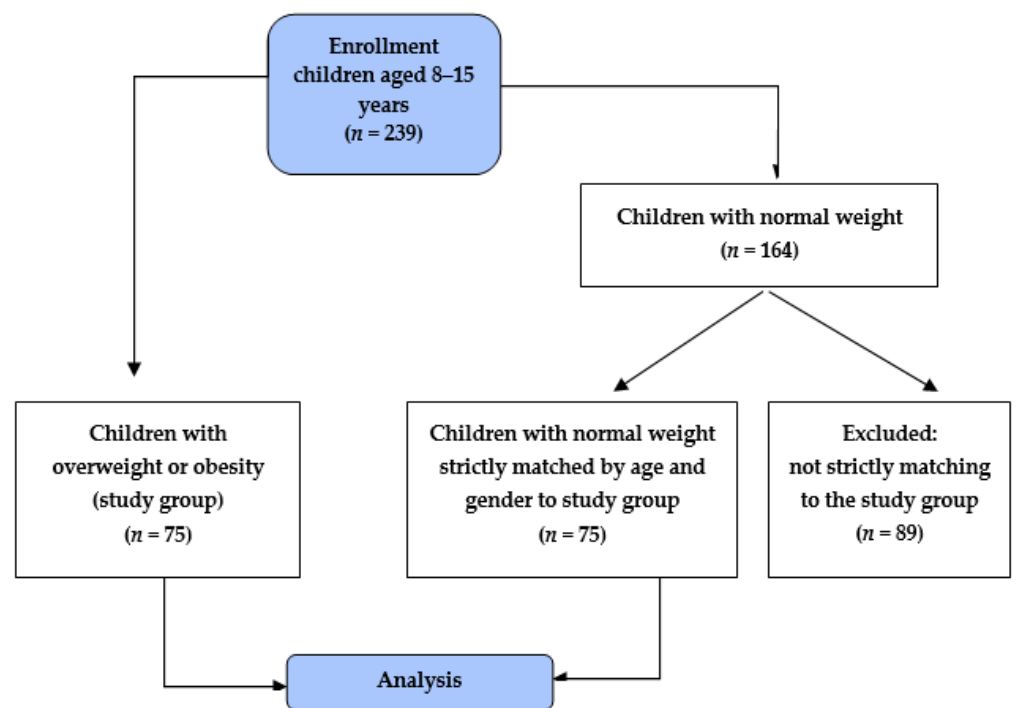
Figure 1. Flow chart demonstrating the selection of the study participants.